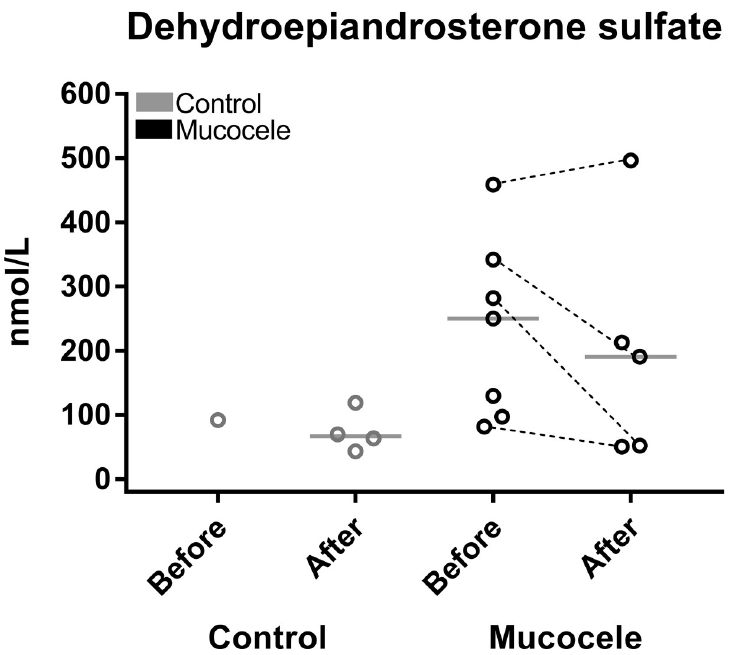
Fig 2. Measurements of serum dehydroepiandosterone sulphate (DHEAS) concentrations before and 1 hour after administration of cosyntropin to control dogs and dogs diagnosed with gallbladder mucocele formation. Data points represent individual dogs with concentrations above the lower limit of detection. Before and after refer to concentrations measured prior to and following administration of cosyntropin, respectively. Dashed lines indicate dogs for which a measurable concentration of DHEAS was obtained both before and after administration of cosyntropin. Bars represent median. � P < 0.05 Kruskal-Wallis One Way Analysis of Variance on Ranks compared to control dogs after administration of cosyntropin (Benjamini-Hochberg FDR � 0.15).